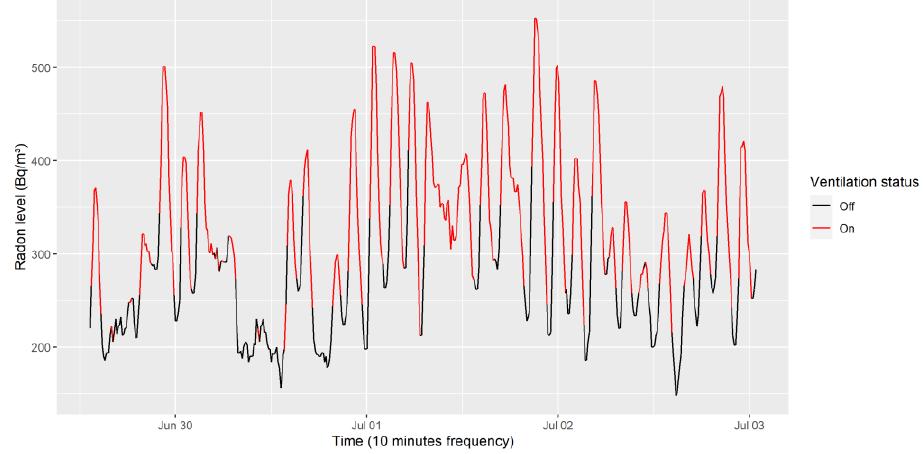
Figure 5. Empirical ventilation influences on radon levels.